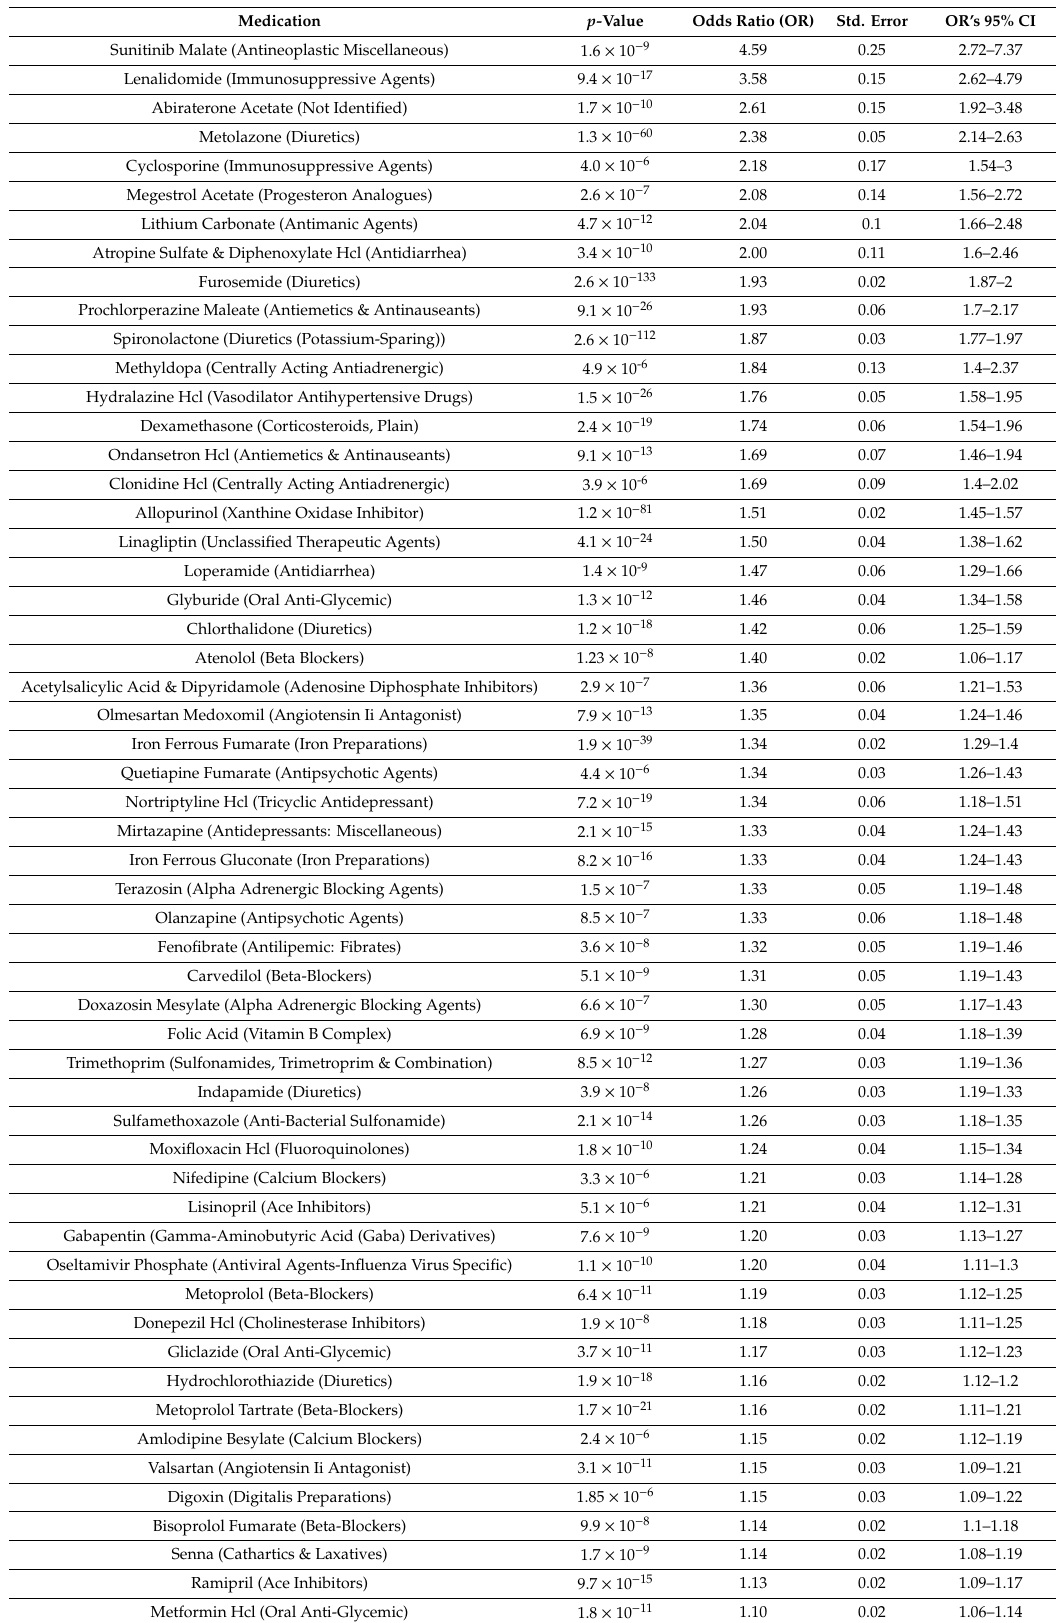
Table 2. List of the individual medications, sorted based on their odds